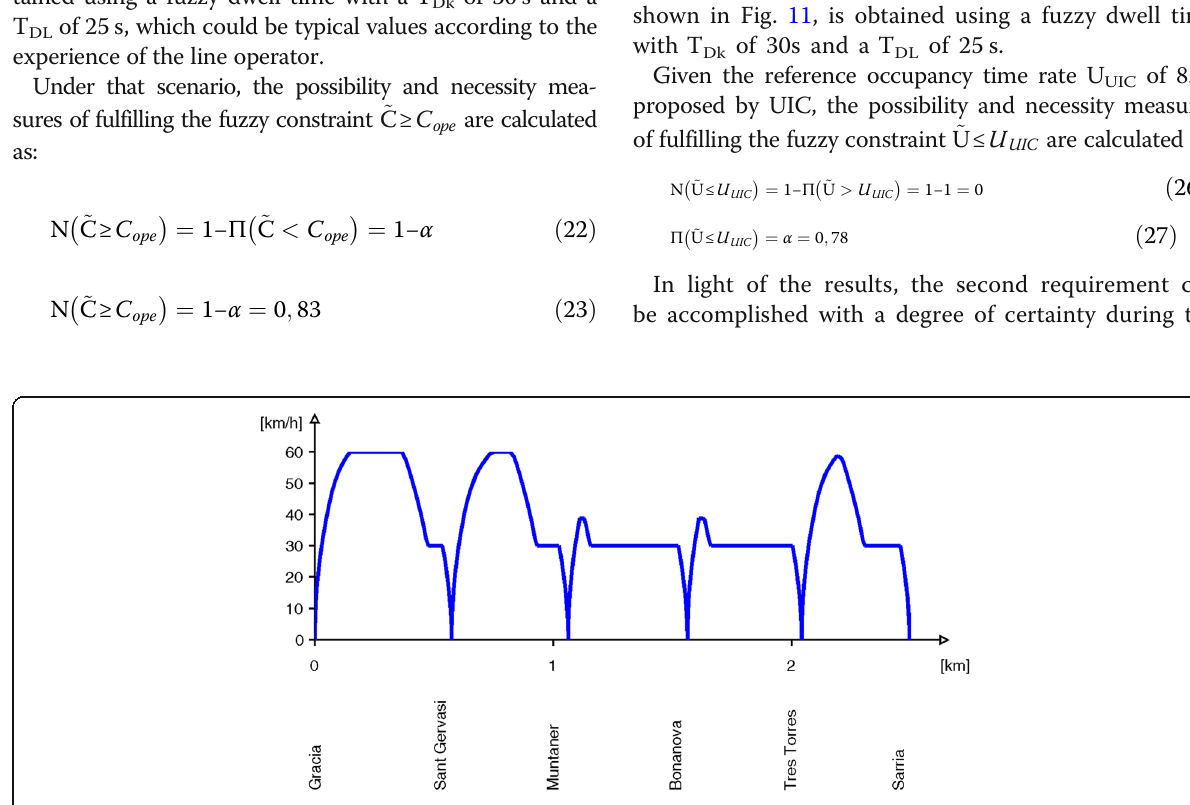
Fig. 8 Simulated speed profile of a train circulating from Gràcia to Sarrià using the ATP system. Train not hindered by other circulations and stopping at all